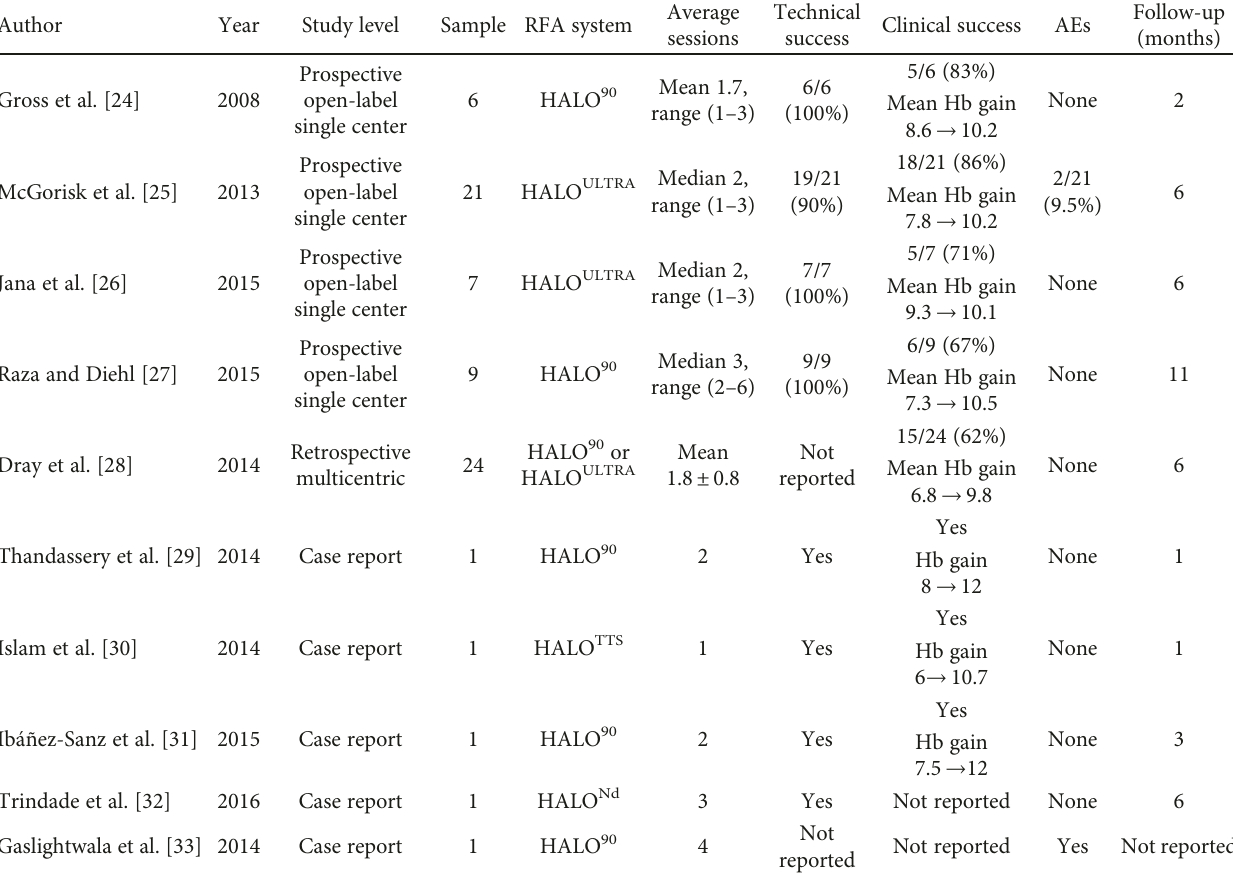
Table 2: Current available evidences on treatment of GAVE with radiofrequency